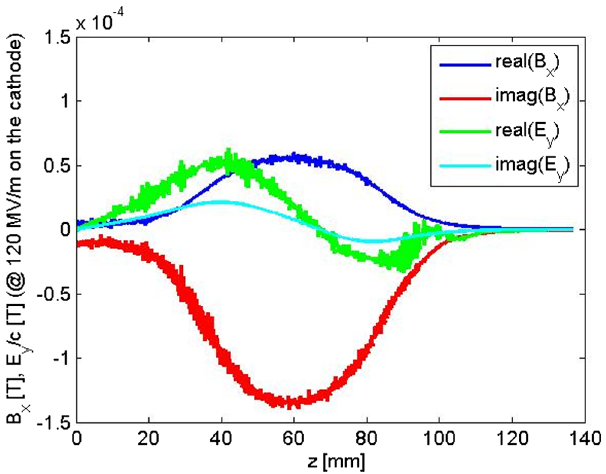
FIG. 32. Transverse voltages integrated along the gun as a function of the launching